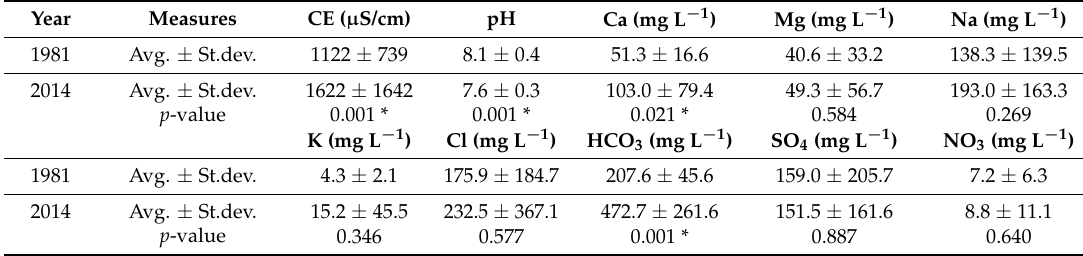
Table 2. Average, standard deviation ( ± 1 σ ) and p -values of various physicochemical parameters for the Tecate